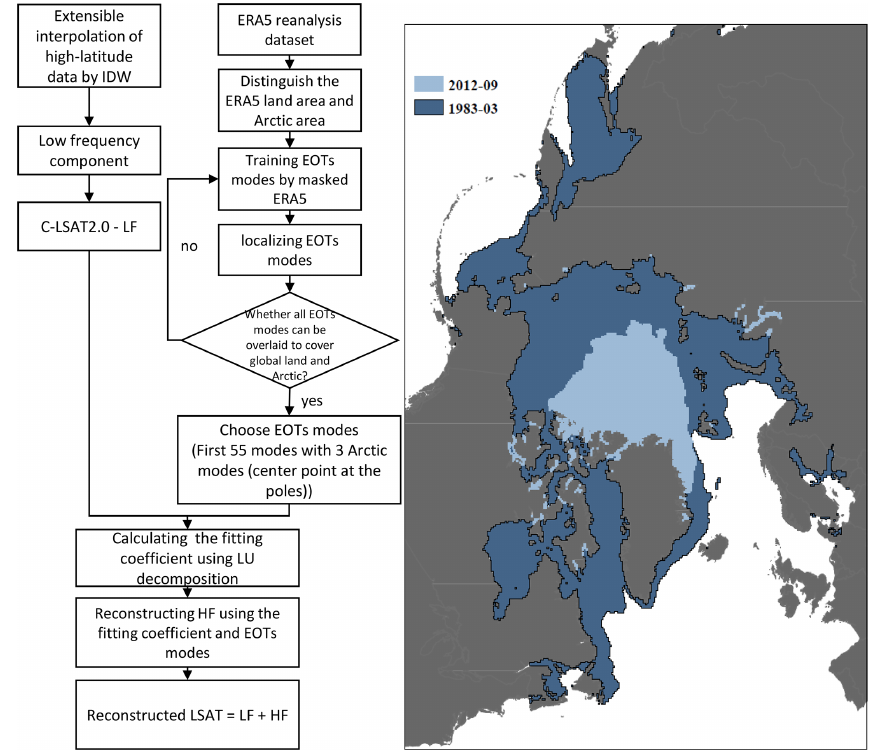
Figure 4. Reconstruction process of Arctic sea ice ST (left); comparison of maximum sea ice extent (sea ice extent in March 1983, shaded in dark blue) and minimum sea ice extent (sea ice extent in September 2012, shaded in light blue) distribution (right).